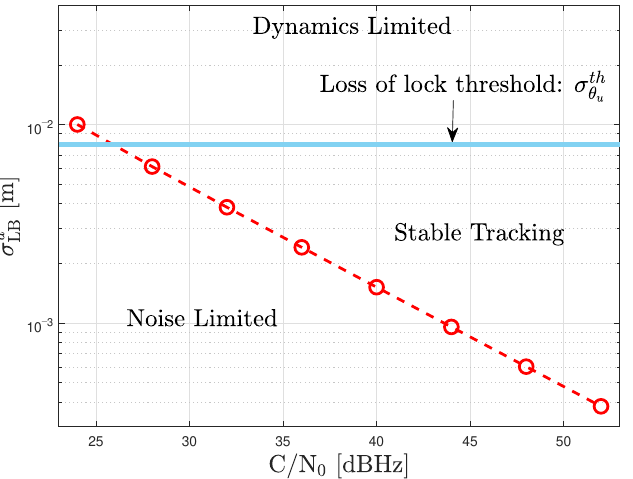
Figure 12. Square root CRB of the un-smoothed carrier phase error at different C / N 0 levels, τ int = 20